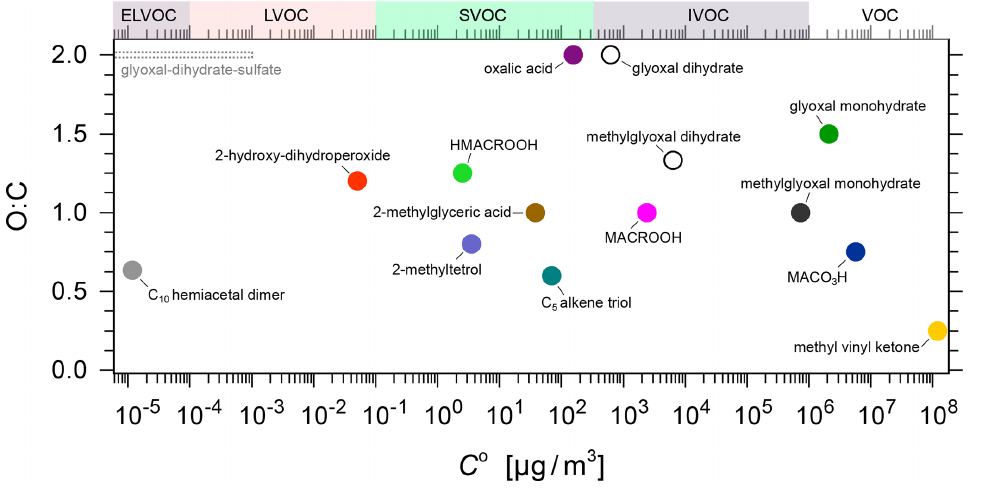
Figure 2. The O : C ratio vs. pure component saturation mass concentration C 0 for the model system components (coloured solid symbols). Selected other aqueous-phase products from glyoxal and methylglyoxal hydration are shown as open symbols (there are many more that are not shown). The shown C 0 range for the system components at T = 283.15K indicates that the MCM-predicted species are mostly VOCs and IVOCs, whereas the selected higher generation products are SVOCs, LVOCs, and